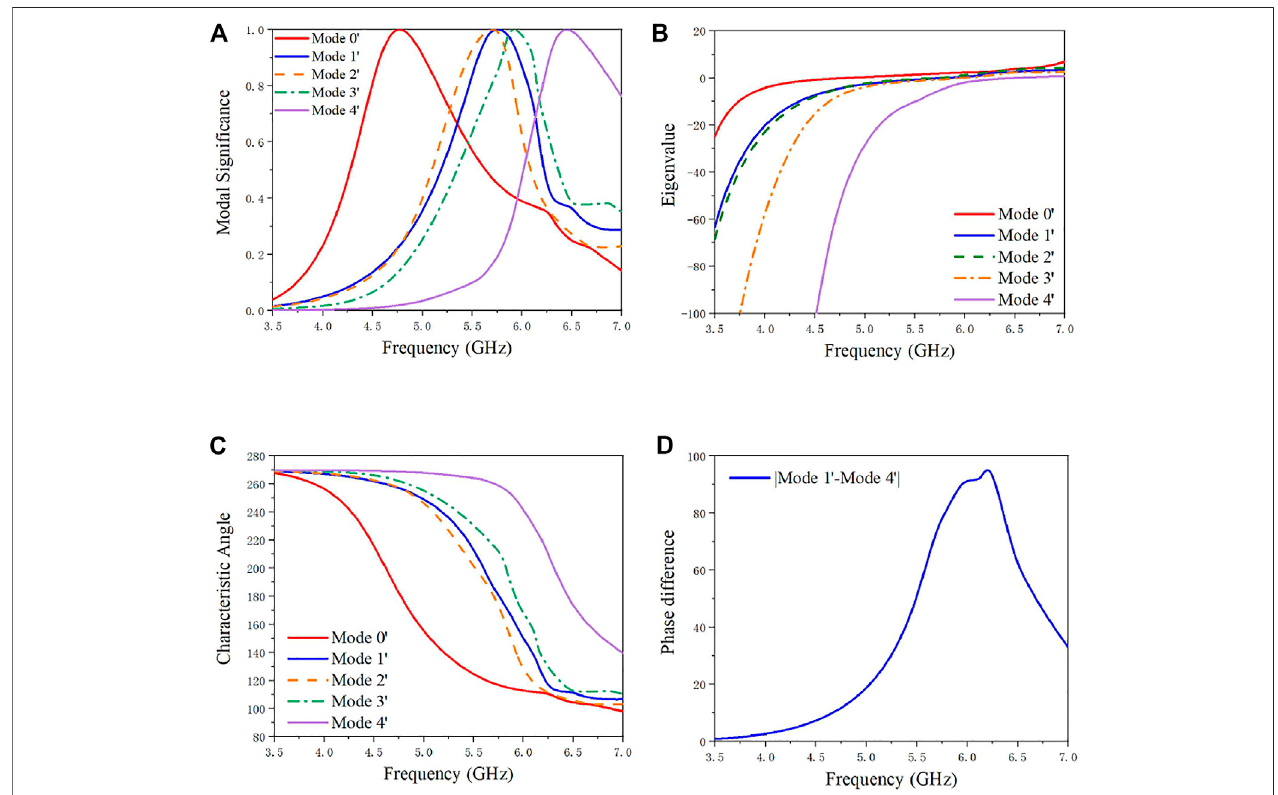
FIGURE 5 | CMA of the overall structure: (A) MS; (B) Eigenvalue; (C) CA; (D) CA difference.